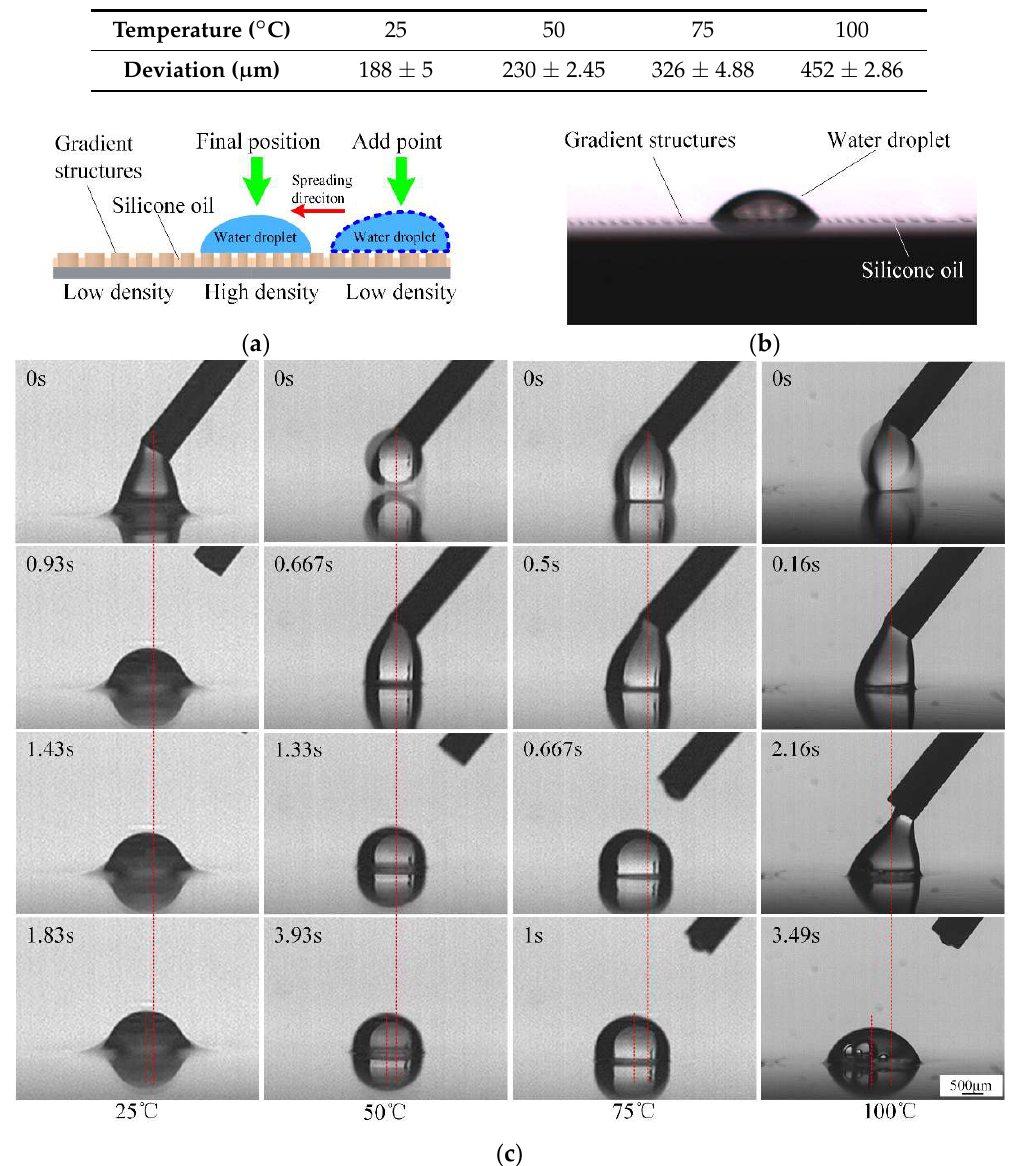
Table 1. Deviation distance of droplet along the gradient’s orientation.